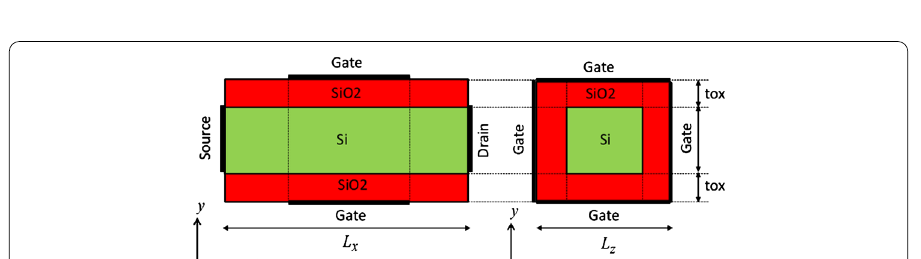
Figure 1 SiNW transistor. Cross sections of the Gate-All-Around SiNW transistor